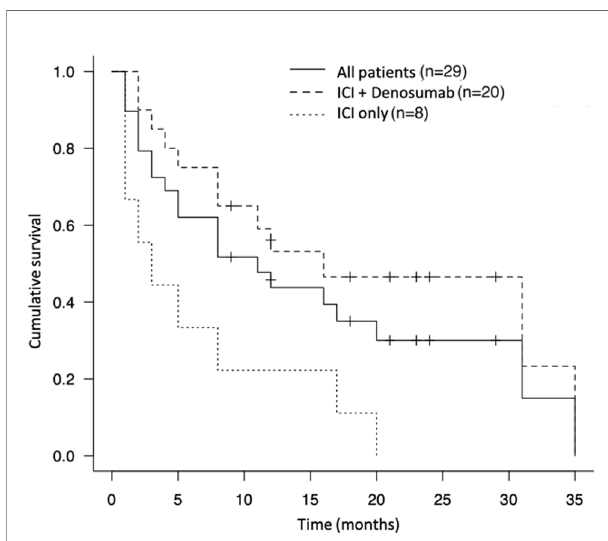
FIGURE 2 | Kaplan-Meier survival curve of the therapeutic effect of immune checkpoint inhibitor and denosumab and immune checkpoint inhibitor alone.